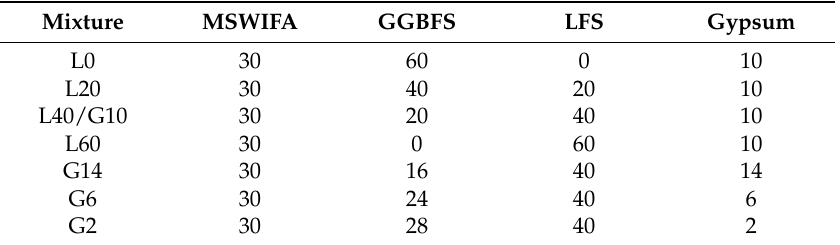
Table 2. Mixture designs of the prepared samples (in mass %).